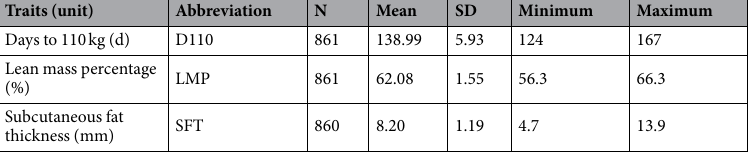
Table 3. Descriptive statistics of analysed obesity-related traits in a commercial pig